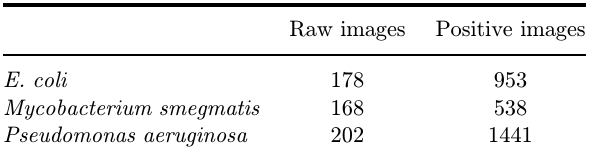
Fig. 3. Flowchart of strategy for generating positive samples. Table 1. A summary of the number of raw images and positive